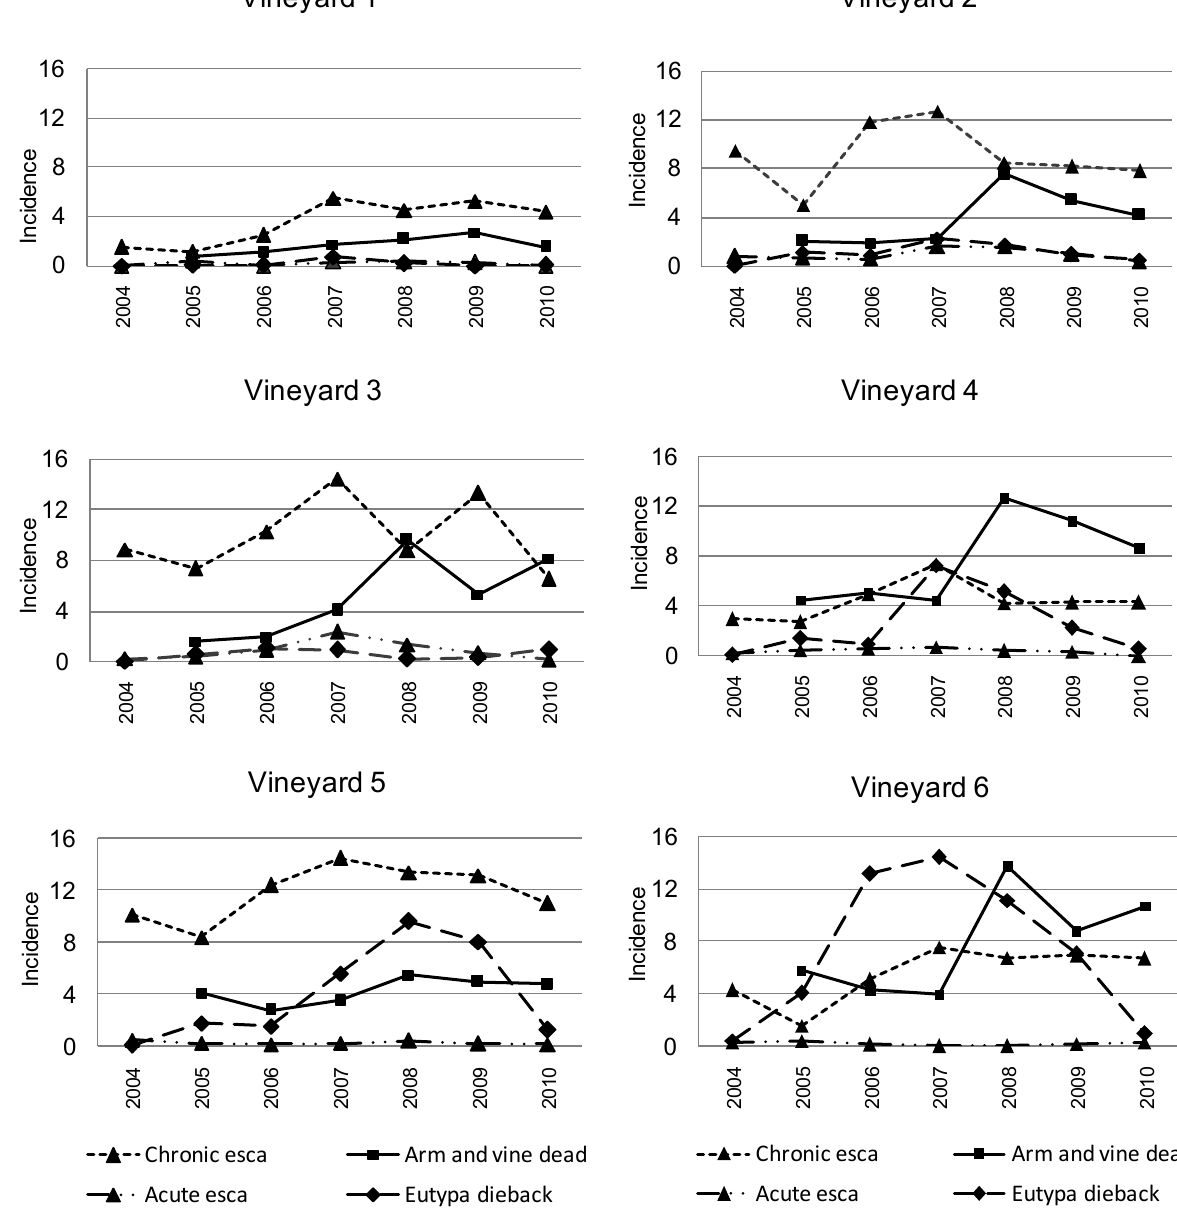
Figure 1. annual incidence of chronic and acute esca of grapevines, Eutypa dieback foliar symptoms, and dead vines (cor- don or trunk) from 2004 to 2010 in the 6 surveyed